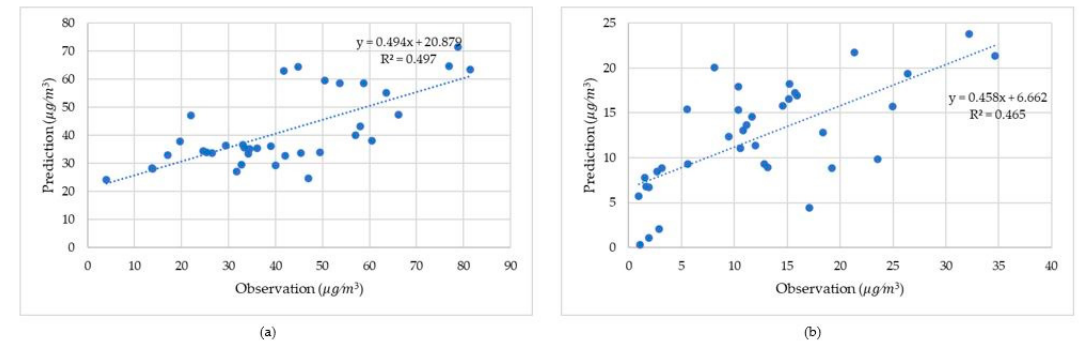
Figure 9. Verification using GTWR based on observations regressed against predictions. ( a ) PM 10 ( b )